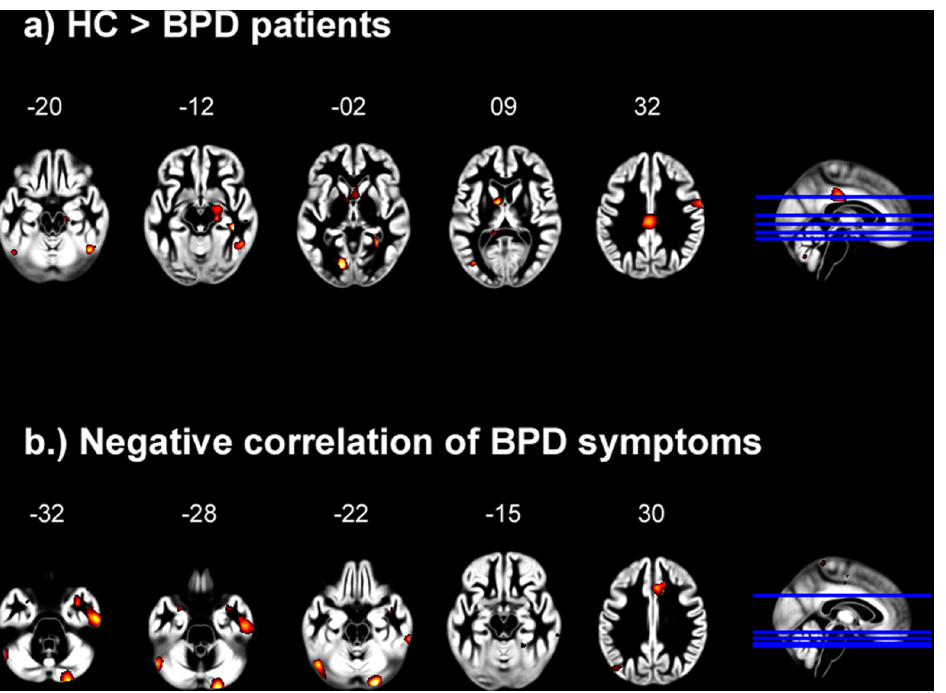
Figure 1. Whole-brain maps illustrate smaller gray matter volumes in patients with borderline personality disorders compared to healthy controls (1a) and negative correlations between gray matter volume and the severity of BPD symptoms (1b). For visualization purposes, the statistical maps were thresholded at T . 2.5. Size and location of clusters are reported in Table 1 and 2.